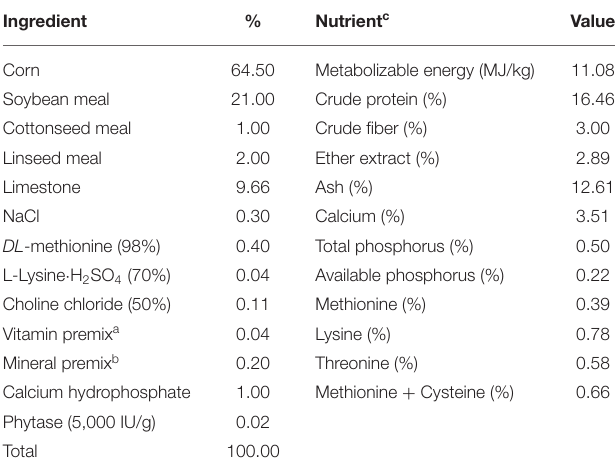
TABLE 1 | Ingredients and composition of the basal diet (as fed